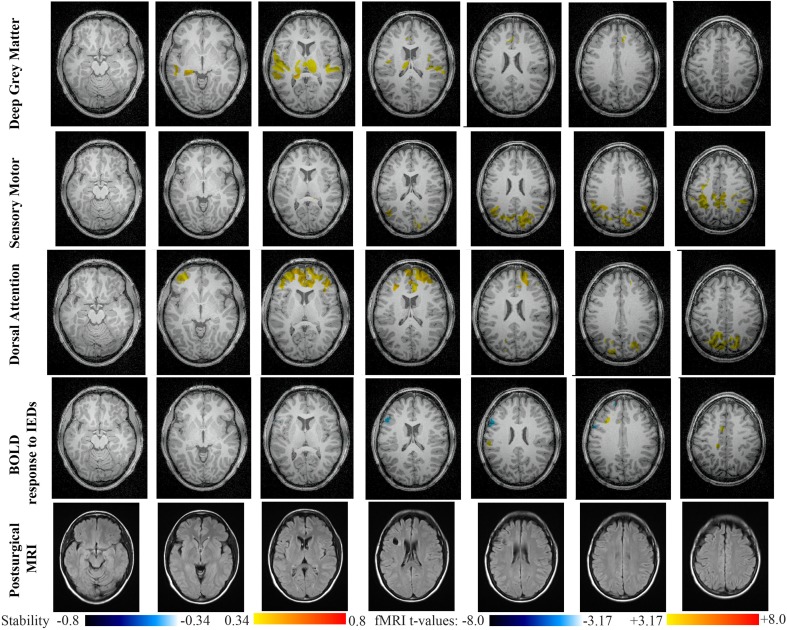
Evaluation of DANI on Patient 5 with left frontal FCD. Results are presenting most salient stability changes observed in Cmapn followed by a t-map of the BOLD response to epileptic discharges and a postsurgical FLAIR MRI, all resampled in the native anatomical MRI space of the patient. Most salient stability changes observed for Cmapn of Deep Gray Matter, Sensory Motor, and Dorsal Attention networks are presented. No networks were involved in significant interactions of modularity changes at p < 0.001. Same colormap conventions than in Figure 6.